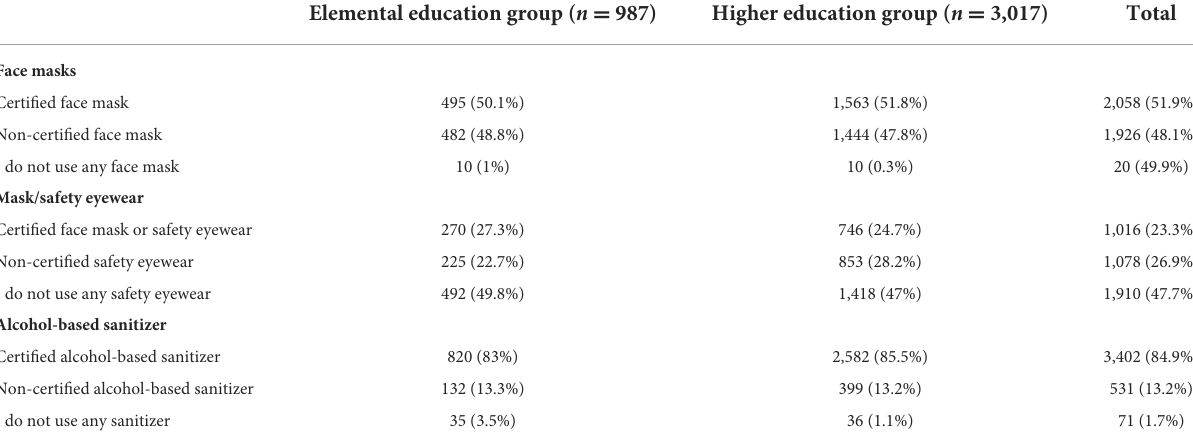
TABLE 4 Preventive measures usage against COVID-19 by educational